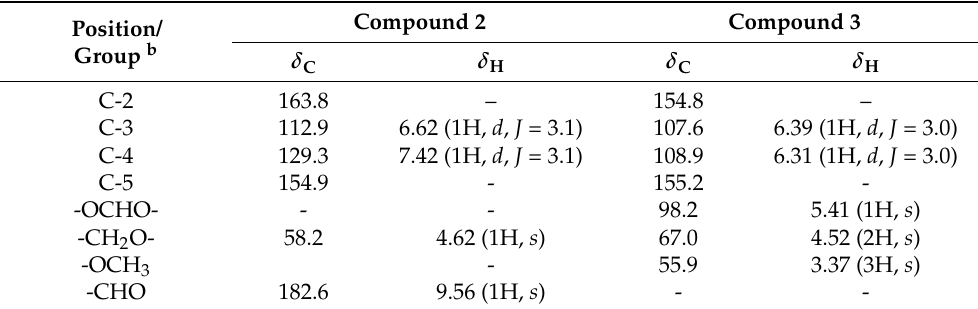
Figure 3. Structures of MRPs identified in dried Prunus spinosa fruits. Table 2. 1 H NMR and 13 C NMR spectral data of the compounds isolated from the fruits of Prunus spinosa (methanol- d 4 ) a